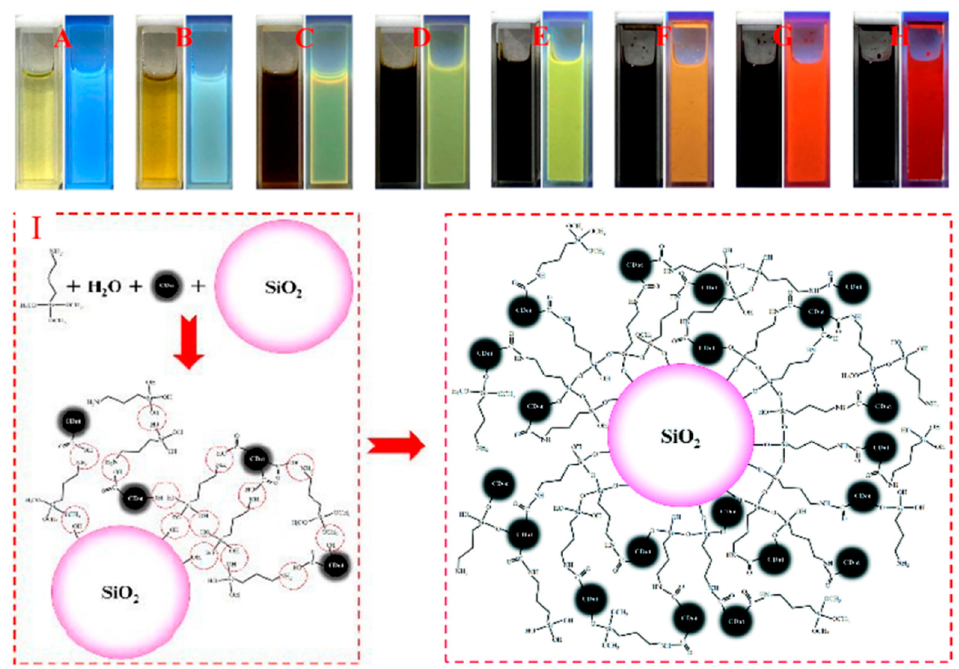
Figure 4. Images of CNSs solutions ( A – H ) with concentrations (6–240 mg/mL) under daily and UV light ( λ ex. = 365 nm). Scheme of CNSs/SiO 2 formation mechanism ( I ). Reprinted with permission from [40], Royal Society of Chemistry 2020.